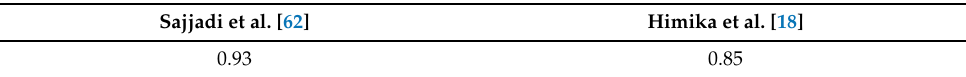
Table 8. Coefficient correlations ( R 2 ) obtained in comparison with individual literature as presented in Figure